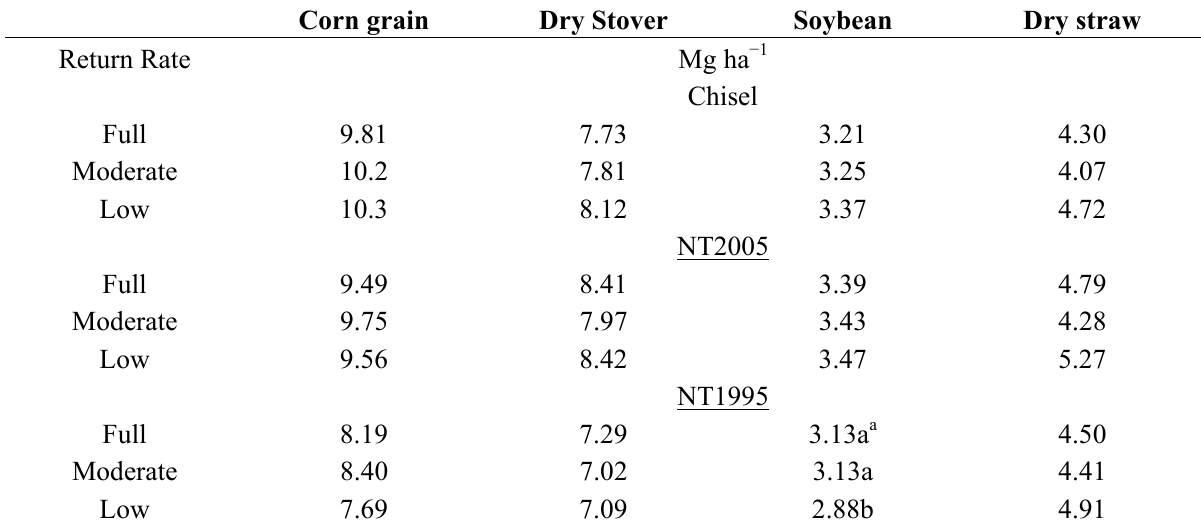
Table 2. Corn grain (15.5 g kg − 1 grain water content), dry corn stover, soybean grain (13 g kg − 1 grain water content) and dry soybean straw averaged from 2005 to 2011 in Chisel and No tillage since 1995 (NT1995) fields and from 2006 to 2011 in no tillage since 2005 (NT2005) field.